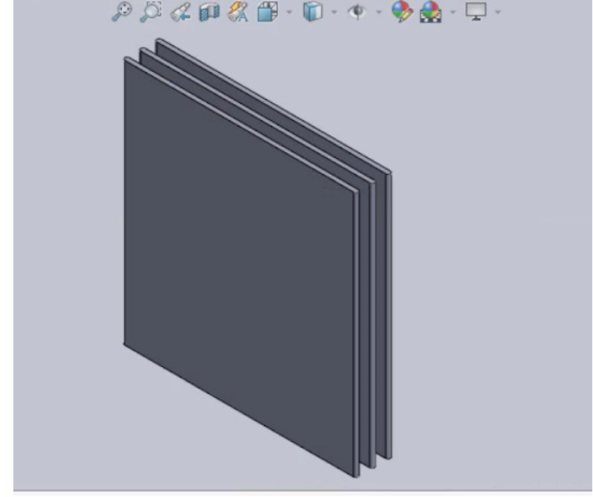
Figure 4. Drawing Mimicking COBOD wall configuration [25].